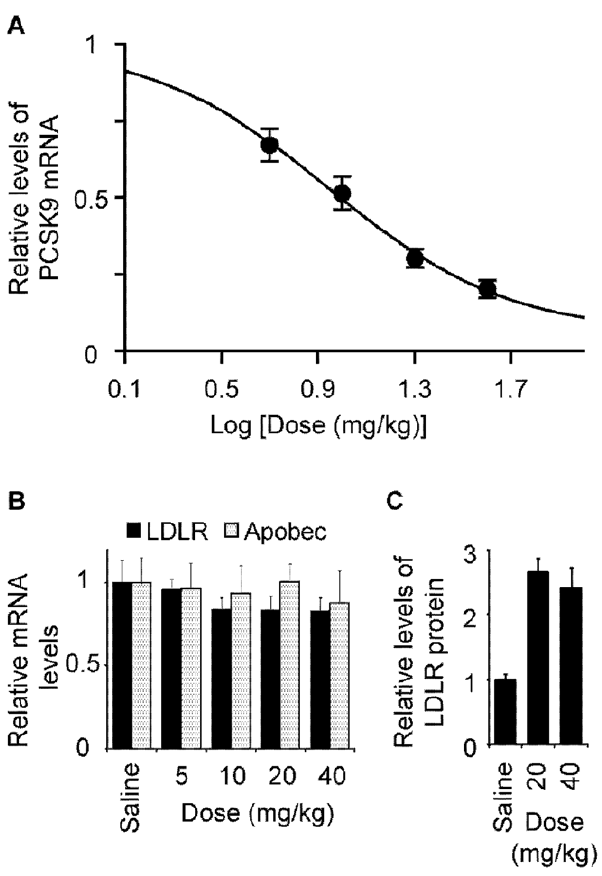
Figure 7. Dose-dependent PCSK9 mRNA response in mice after a single i.v. injection at 5–40 mg/kg. ( A ) Dose-response curve of PCSK9 mRNA levels in the liver (mean and SEM, n=5), where the ED50 estimation is 9 mg/kg and maximum effect 95% reduction of the PCSK9 mRNA. ( B ) There is no change in mRNA levels of LDLR or Apobec. ( C ) LDLR protein is up-regulated 2–3 fold in the treated animals in the high dose groups. (Mean and SEM, n=4–5).